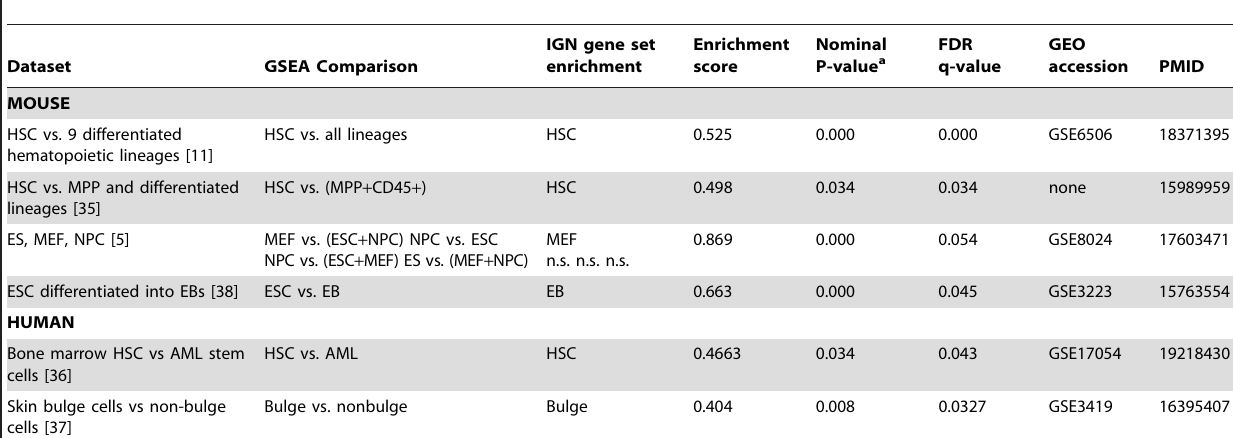
Table 2. Enrichment of imprinted genes in somatic stem cell populations from published gene expression studies.